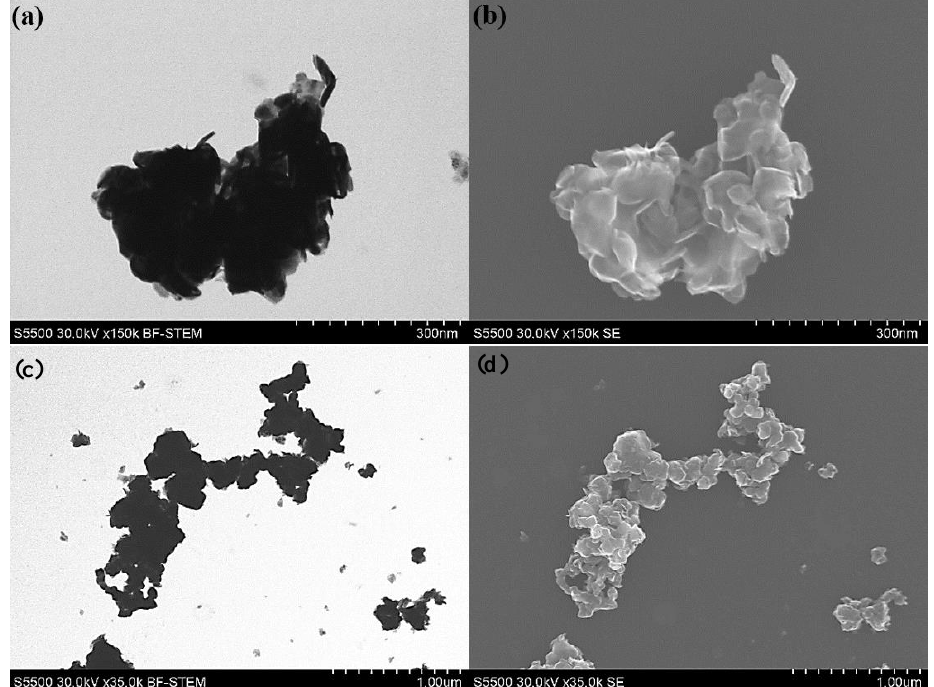
Figure 8. Images of synthesized MoS 2 particles in ( a , c ) the bright-field scanning transmission electron microscopy (BF-STEM) and ( b , d ) in secondary electrons (SE) modes.